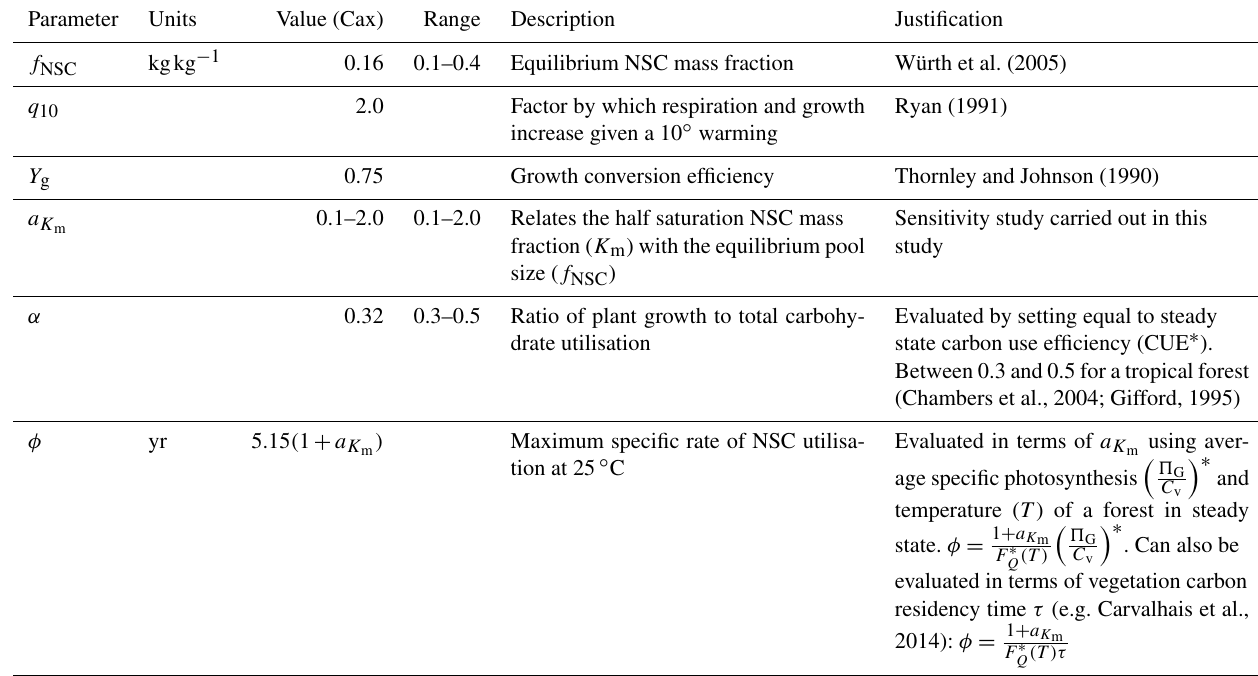
Table 1. Parameters in